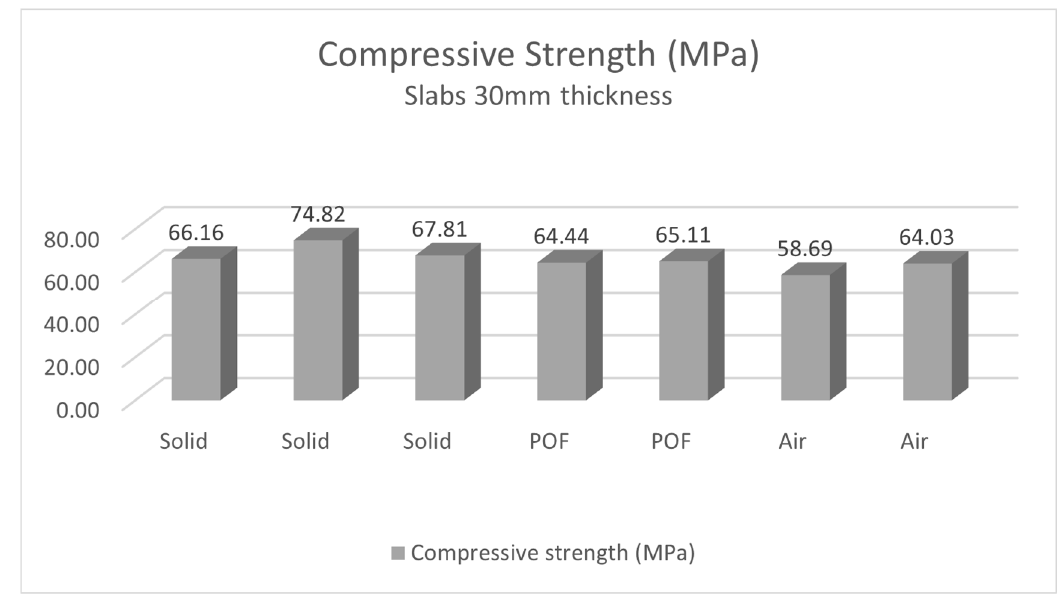
Figure 37. Compressive strength of slabs of thickness 30 mm.